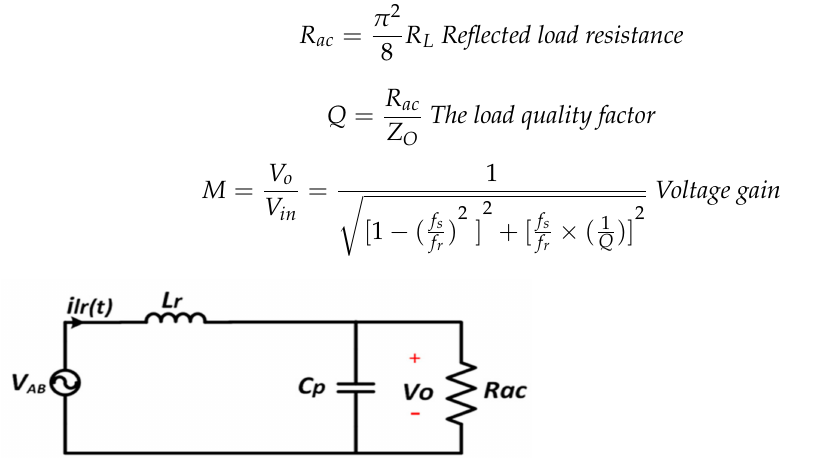
Figure 26. Equivalent circuit of the DC-DC parallel resonant converter